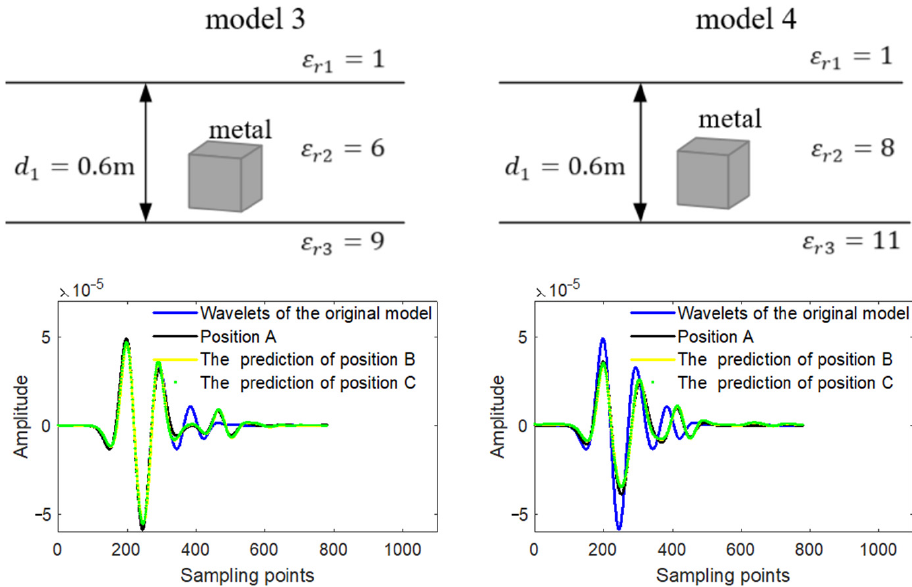
Figure 11. Wavelet prediction of derived models.